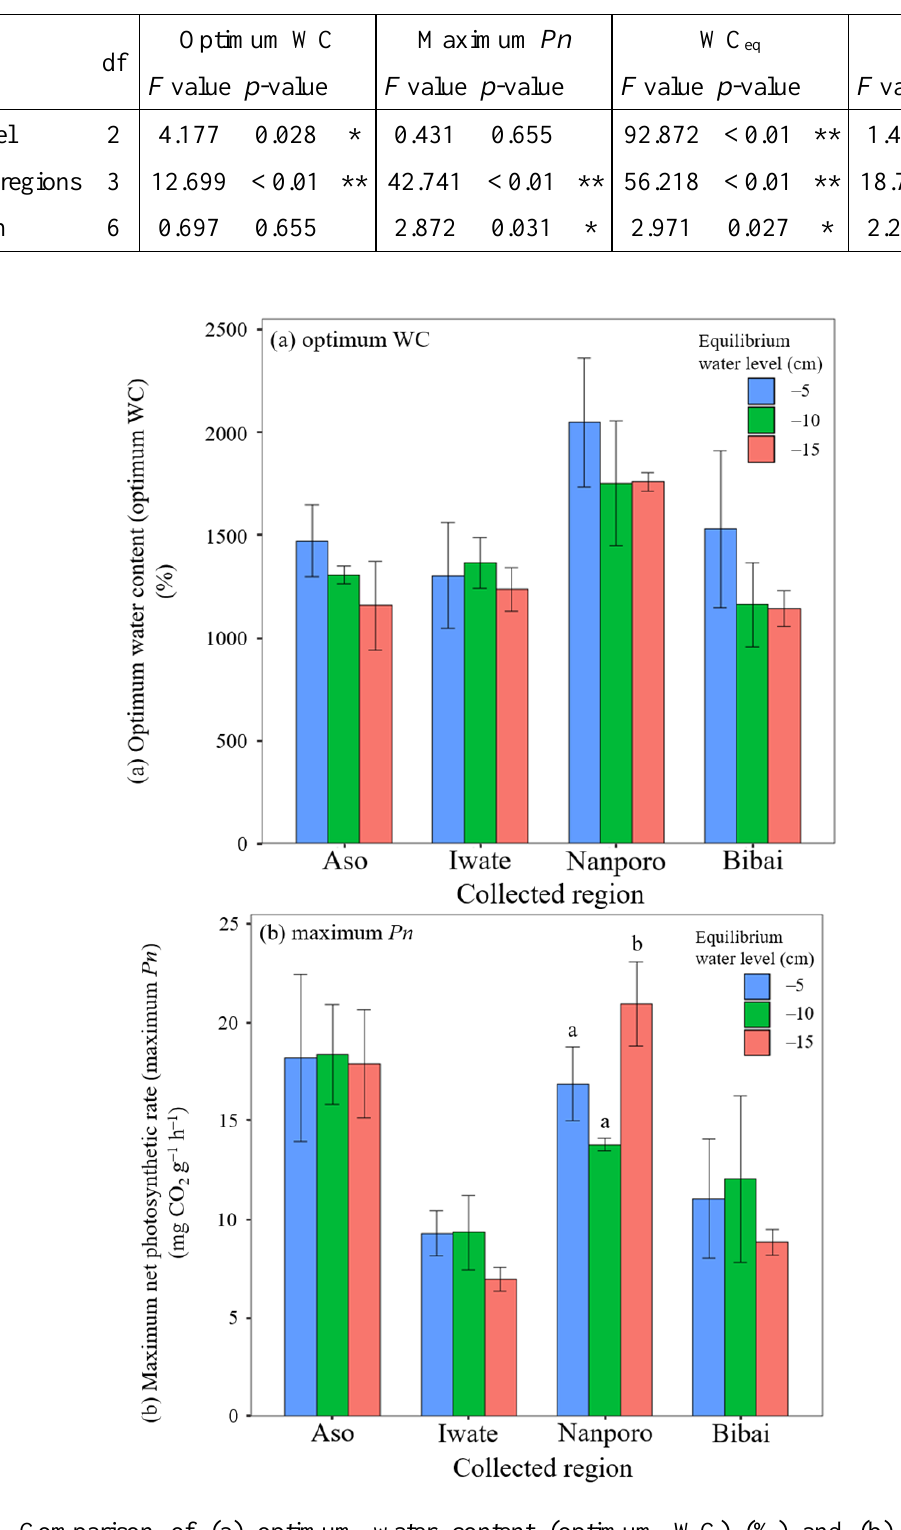
Table 2. Two-way factorial ANOVA showing the effects of water level and collected region on the optimum water content (optimum WC), maximum net photosynthetic rate (maximum Pn ), equilibrium water content specific to the water level (WC ), and net photosynthetic rate at WC ( Pn ) in the samples from Aso, eq eq eq.WL Iwate, Nanporo and Bibai. Key: df = degrees of freedom; * significant at p < 0.05, ** significant at p < 0.01.